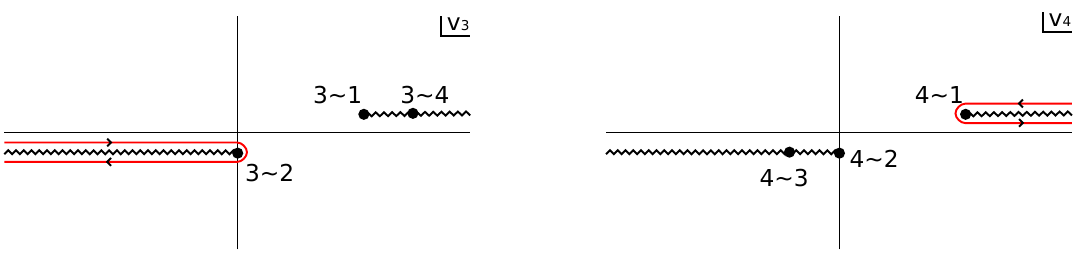
Figure 1 . The continuation of v 3 ; v 4 in the case where 0 < u 3 < u 4 < 1. We begin by integrating both variables over the real axis. We deform the v 3 contour in the lower half-plane to pick up the discontinuity across the branch cut associated with the 3 (cid:24) 2 singularity, giving the [ O 3 ; O 2 ] commutator. We deform the v 4 contour in the upper half-plane and pick up the [ O 4 ; O 1 ]